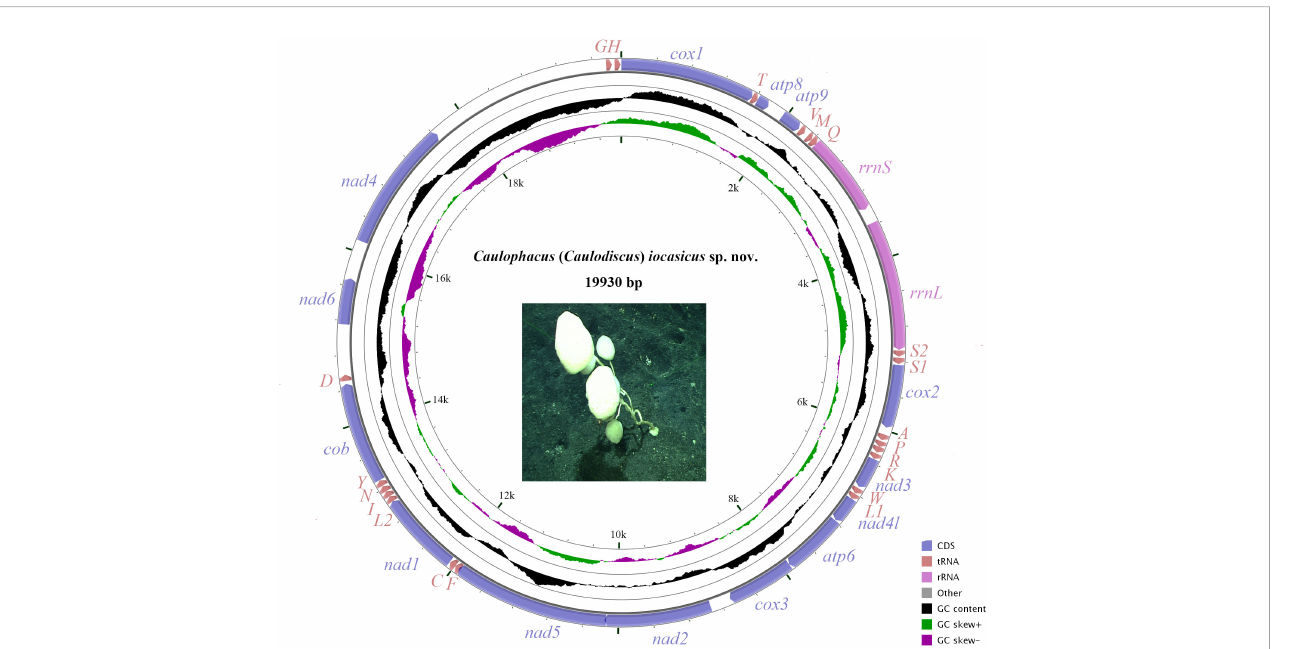
FIGURE 4 The organization of the mitochondrial genome of Caulophacus ( Caulodiscus ) iocasicus sp. nov. Genes for protein coding genes are shown with standard abbreviations. 12S and 16S ribosomal RNA genes are are indicated as rrnS and rrnL , respectively. Genes for tRNAs are labeled by one-letter code for their corresponding amino acid.